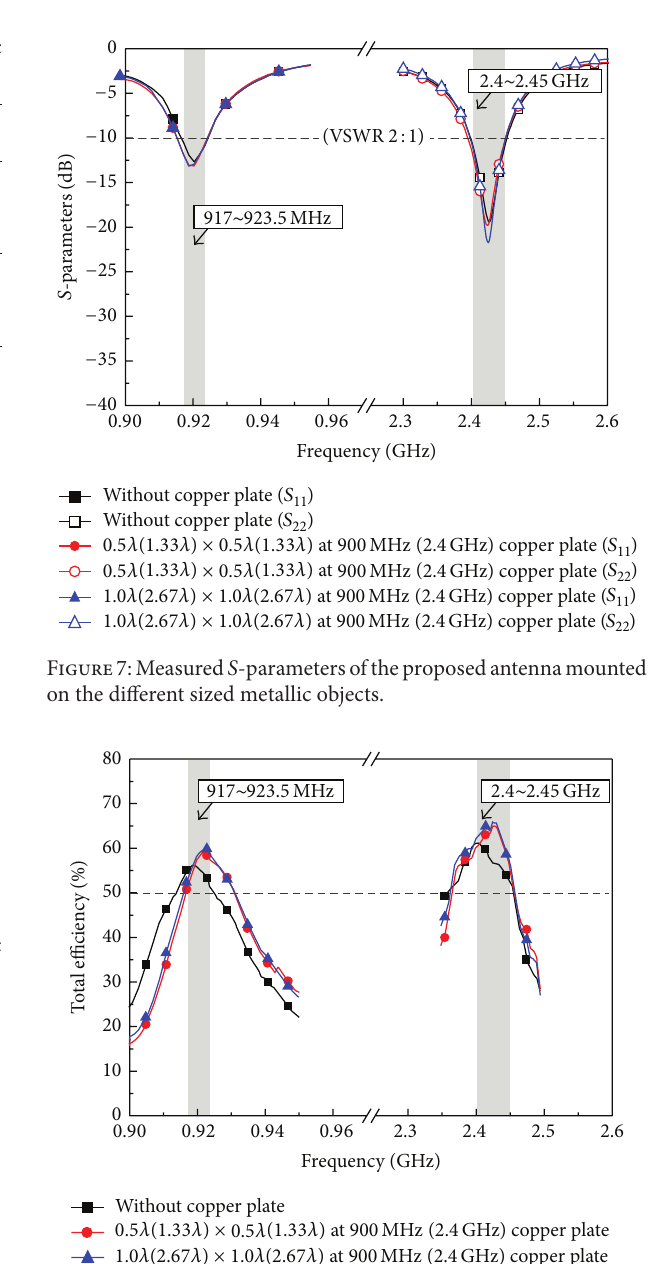
Figure 8: Measured total efficiency of the proposed antenna mounted on the different sized metallic